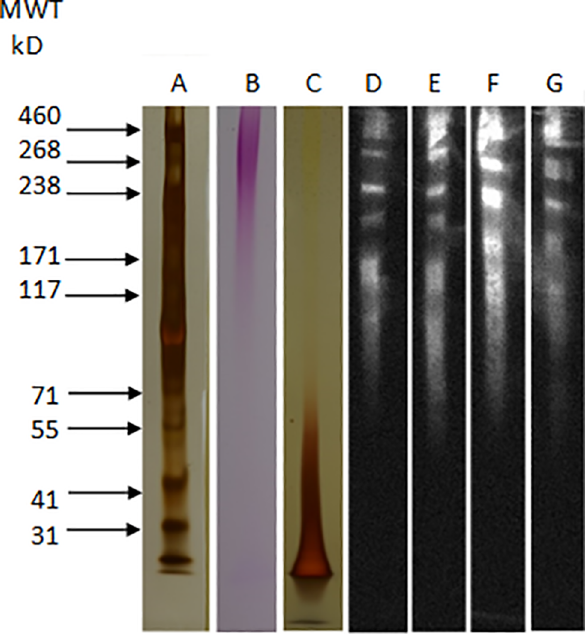
Fig 1. PAGE and Western blot analysis of CMP preparations. CMPs were combinedwith SDS sample buffer containing DTT to yield 1 mg/mL samples: 10ul of each sample was appliedper well in 2–8% Tris acetate polyacrylamide gels and electrophoresed with a Tris/Tricine SDS runningbuffer. Western blot was performed in a standard discontinuous Tris/CAPS buffer. Gel lanes are: Lane A, molecularweight markers; Lane B, polysaccharide-stained CMP; LaneC, silver-stained CMP. Duplicategels were also blotted to nitrocellulose. Lane D & E, 2 independentCMP samples probedwith polyclonal rabbit anti-mannanantibody (Dako); Lane F & G, repeated2 independent CMP samples probedwith polyclonal rabbit anti- C . albicans antibody (Thermo Fisher). Chemiluminescent visualizationof primary antibodybindingused a goat anti- rabbit-peroxidaseconjugateand a Super SignalWest Pico Substrate Kit. These images are representativeof 2 independent preps, whereinD and F represent a single CMP sample that displayedmore activity than the E and G